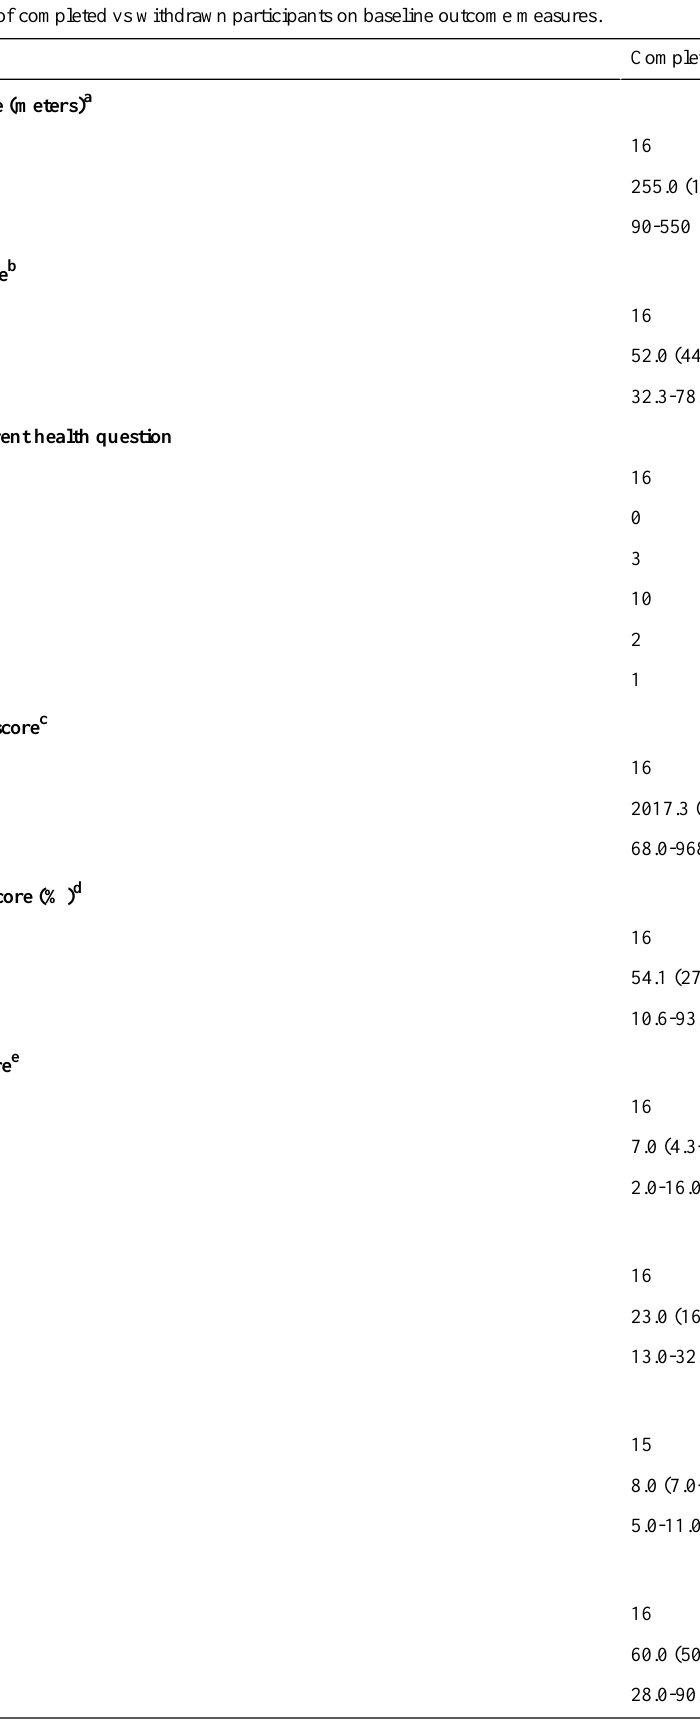
Table 4. Comparison of completed vs withdrawn participants on baseline outcome